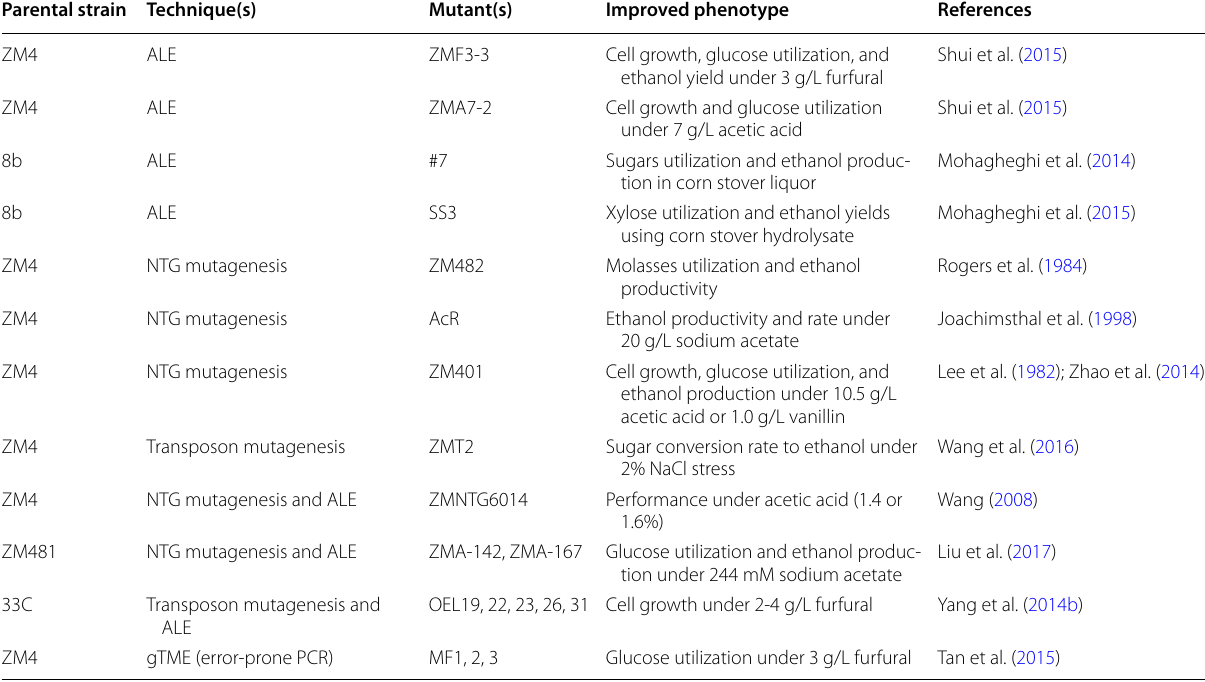
Table 2 Tolerance improved strains obtained by forward genetics approaches Parental strain